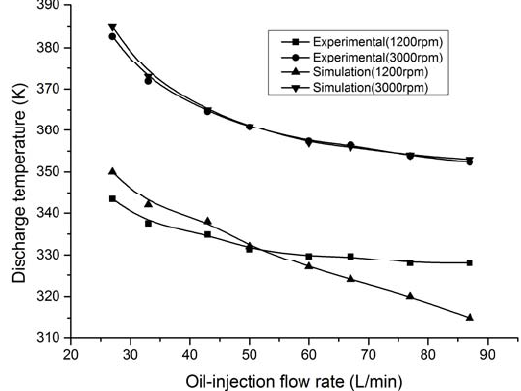
Figure 11. Comparison of experimental and simulated discharge temperature.